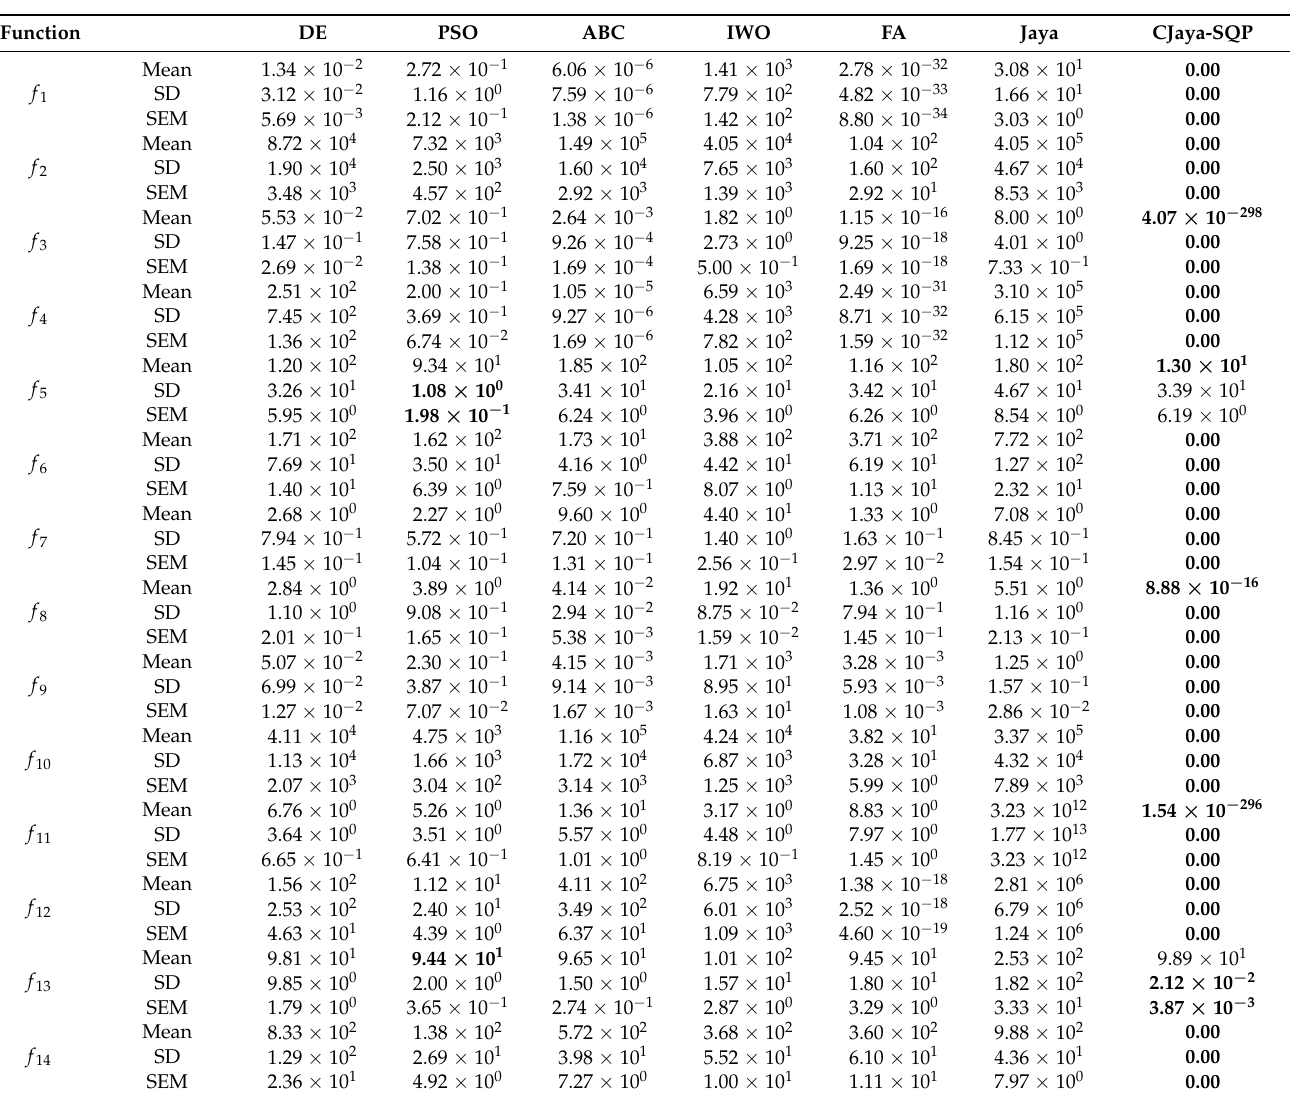
Table 8. Statistical results obtained by comparative algorithms for 100-dimensional functions over 30 runs with 80,000 function